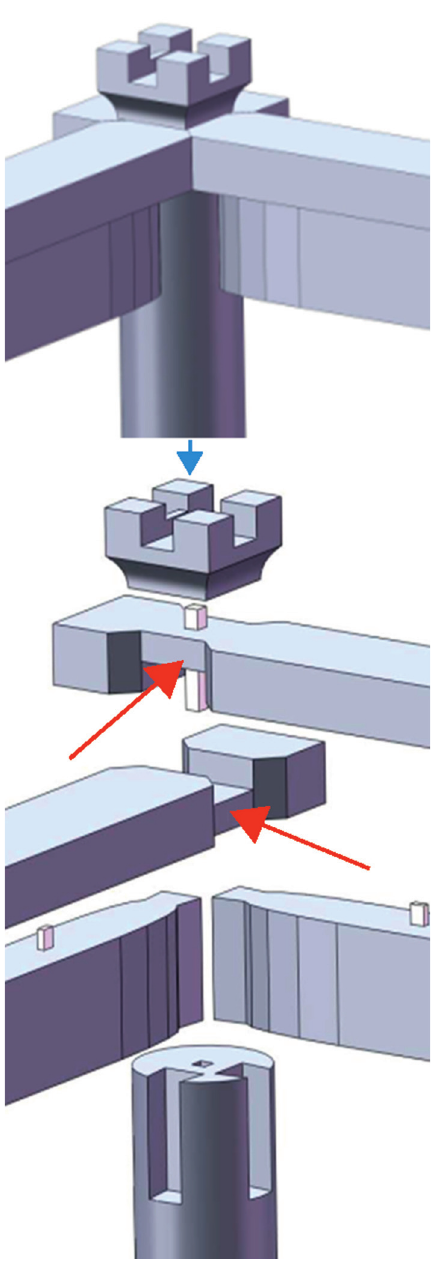
Figure 7: Connection of the beam-column frame. The red arrows indicate the weak parts of this